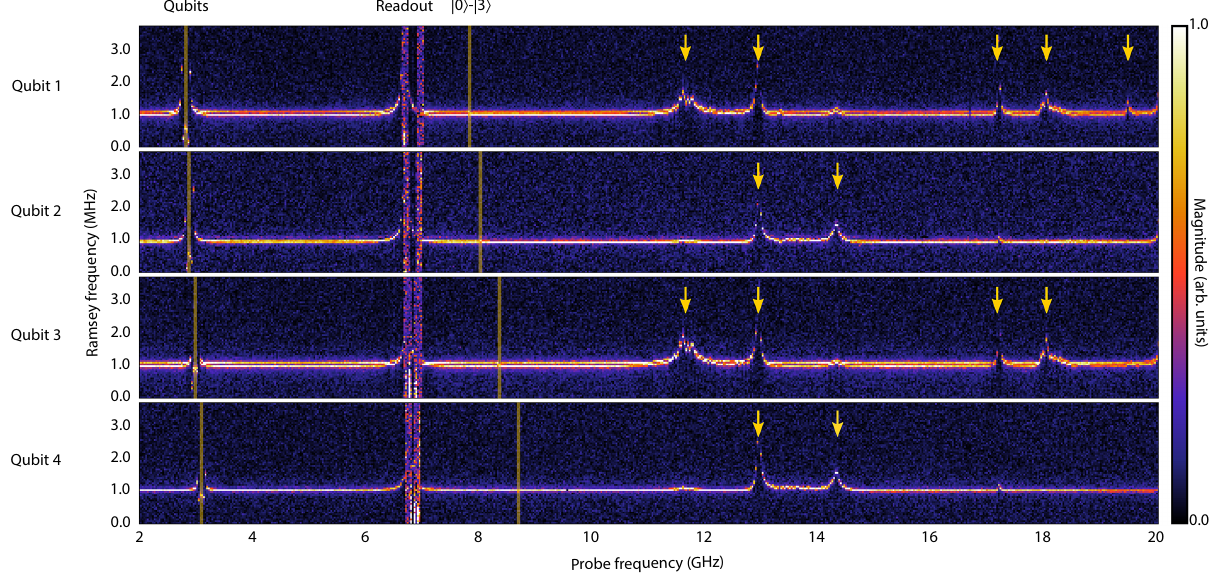
FIG. 9. Experimental package mode evaluation using four qubits. The Ramsey spectra are taken simultaneously from four different qubits while a probe tone is injected through the central transmission line. Note the similarity between the spurious modes (indicated by yellow arrows) measured by qubits 1 and 3, as well as qubits 2 and 4. The orange lines indicate qubit-related features which shift depending on the sensor qubit